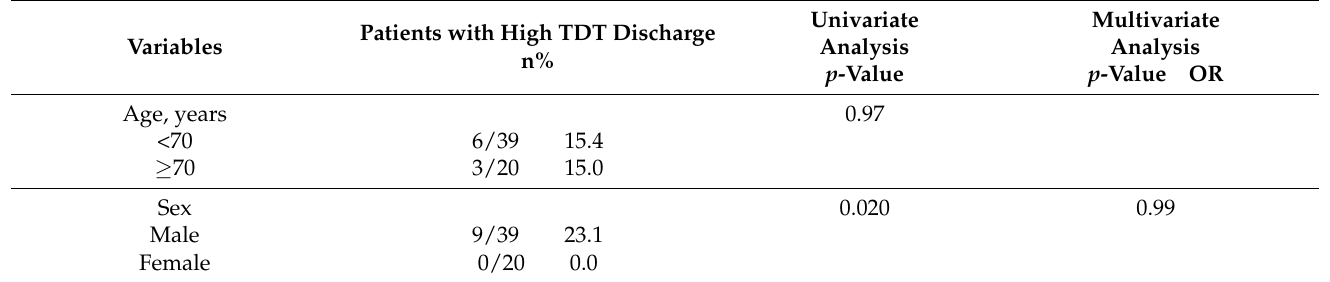
Table 1. Univariate and multivariate analyses of the risk factors associated with a high fecal volume. Patients with High TDT Variables